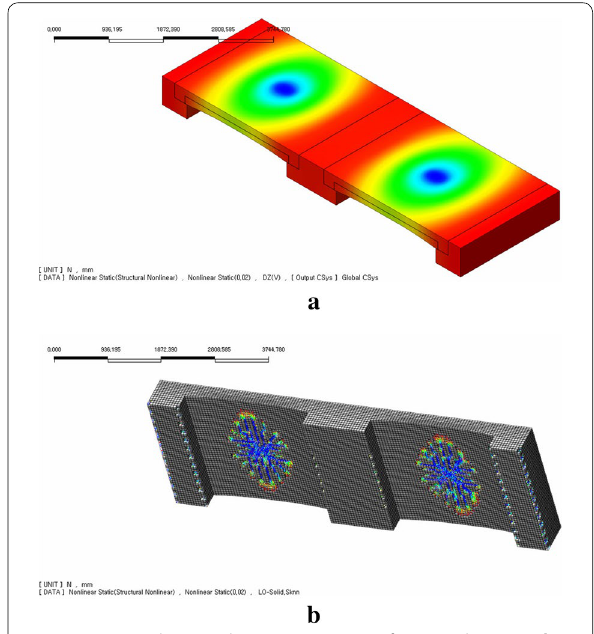
Fig. 21 FEM analysis results (BD). a Contour of FEM analysis (BD). b Crack pattern of FEM analysis (BD).